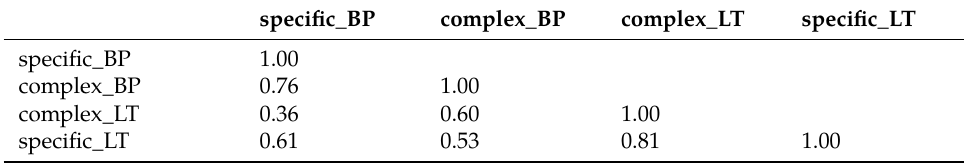
Table 4: Correltation coefficients of contractibility over sample set.